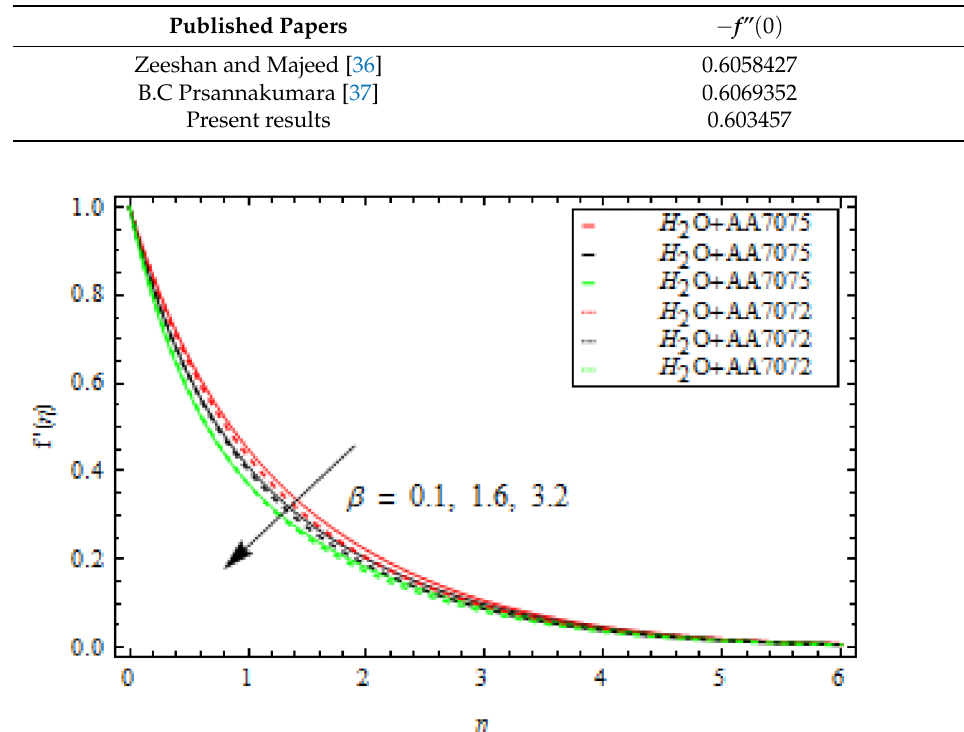
Table 5. Comparison of − f (cid:48)(cid:48) ( 0 ) with literature.